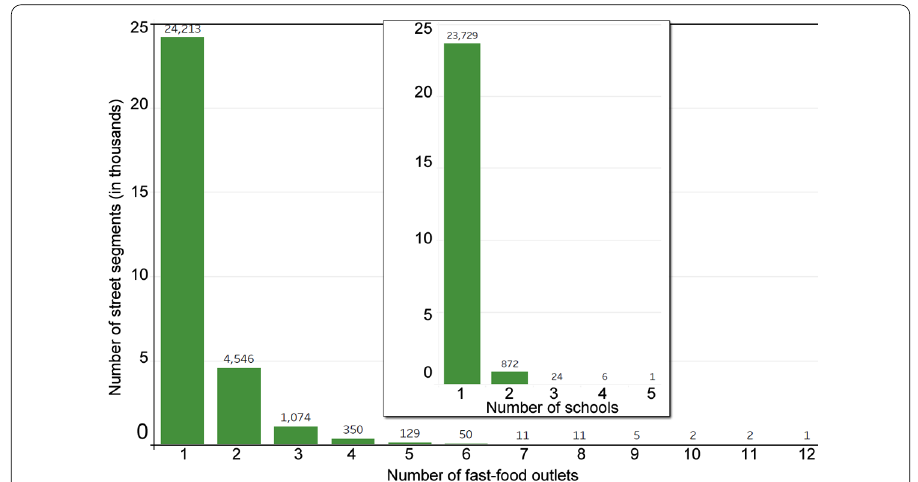
Figure 7 Distribution of the number of fast-food outlets and schools (inset) per street